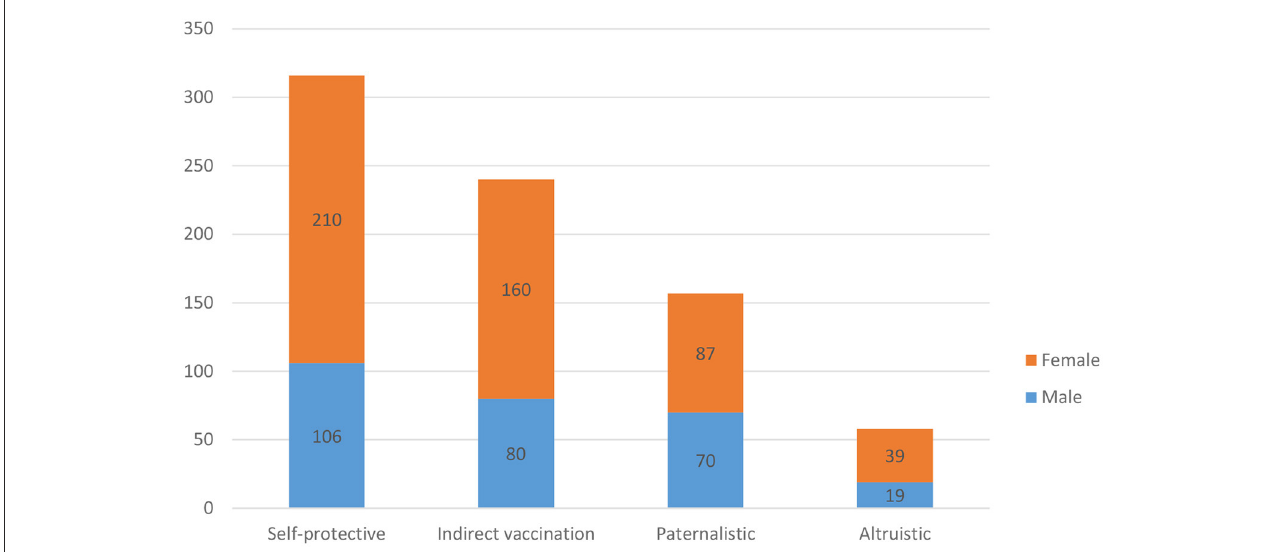
FIGURE5 Respondents’ reason for taking the vaccine according to the categorization of vaccine rationale and gender.